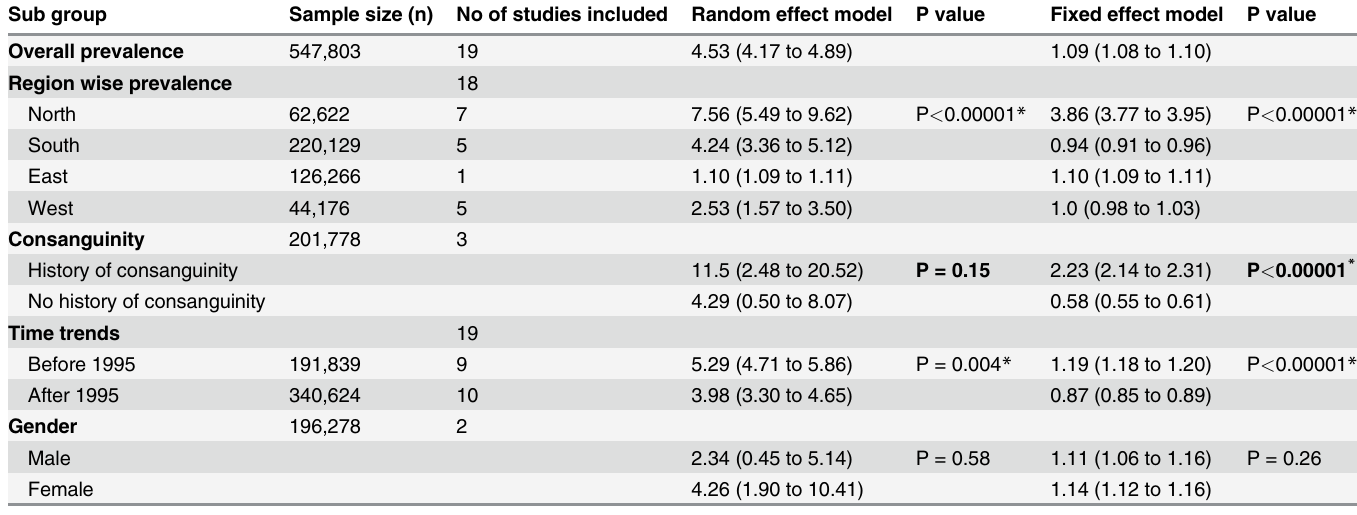
Table 3. Summary table of the data from studies included on neural tube defects; the table depicts comparative data using fi xed and random effects model. Sub